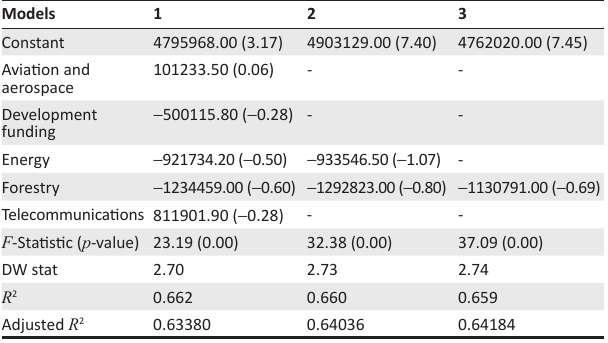
TABLE 8: Regression analysis – total compensation and company industry.